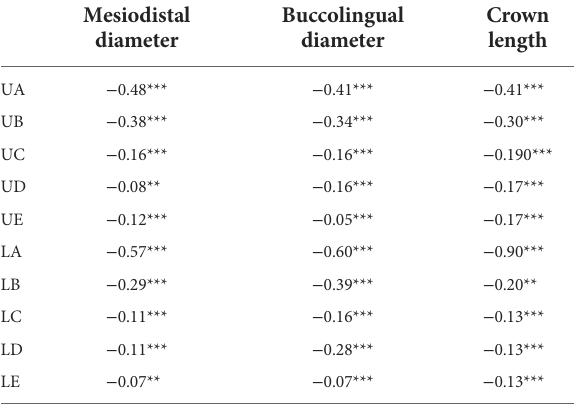
TABLE 13 Difference between mesiodistal diameter buccolingual diameter and crown length of the present total sample and the results of Wang Huiyun ’ s